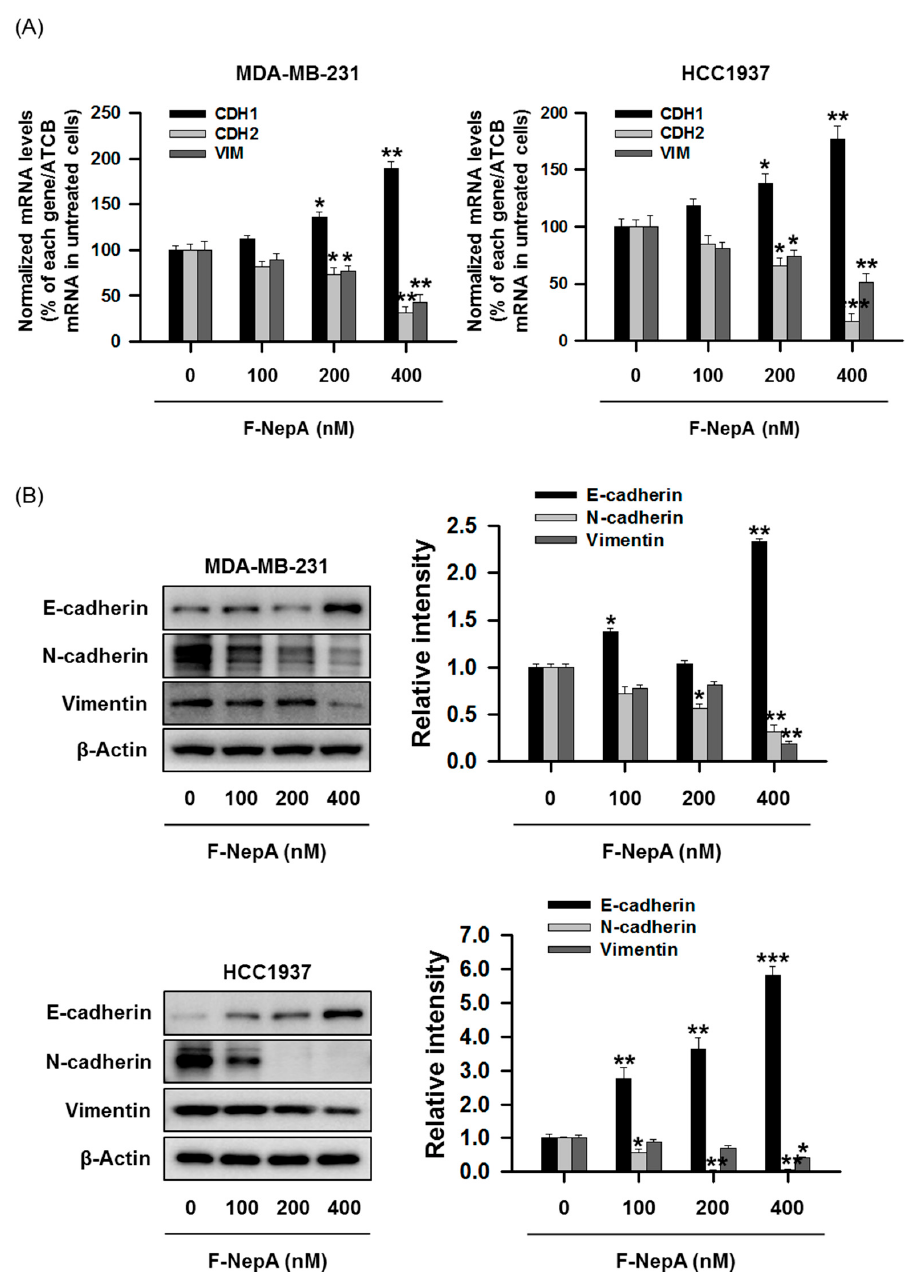
Figure 5. F-NepA regulates EMT gene expression in human TNBC cells. ( A ) MDA-MB-231 and HCC1937 cells were treated with F-NepA at the indicated concentrations for 24 h, and the mRNA levels of CDH1 , CDH2 , and VIM were determined using real-time PCR. ( B ) The protein levels of E-cadherin, N-cadherin, and Vimentin in MDA-MB-231 and HCC1937 cells treated with F-NepA for 48 h were determined by Western blotting. β -Actin was used as an internal control. The relative intensities of the indicated proteins were analyzed semi-quantitatively using NIH ImageJ software. The data are expressed as the mean values ± SD (n = 3) and are representative of three separate experiments. * p < 0.05, ** p < 0.01, and *** p < 0.001 indicate significant differences relative to the vehicle-treated control group.